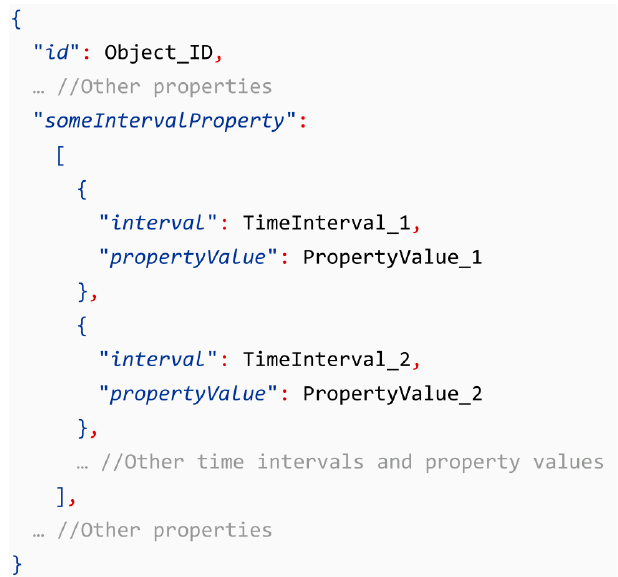
Figure 2. General structure of specifying a time-varying property over different time intervals using the interval property.